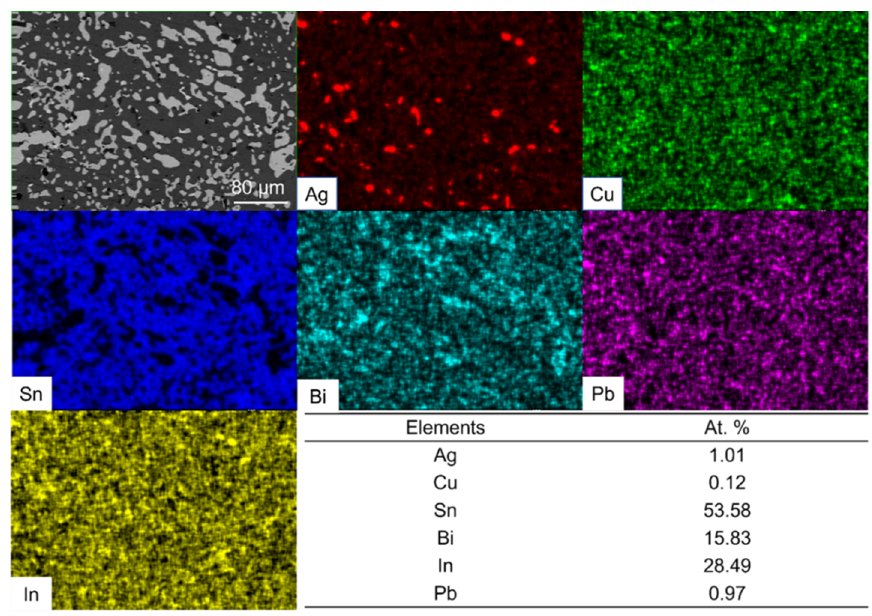
Figure 13. Elemental distribution and atomic percentage results of fully mixed solder joint after 25 days of aging.